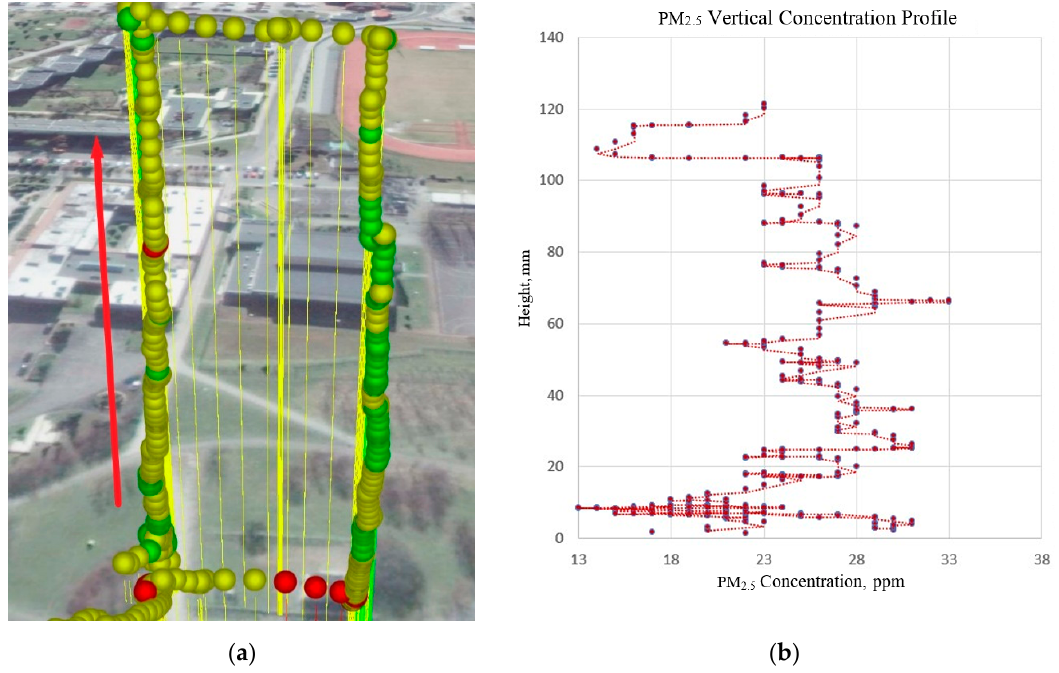
Figure 12. Flight route and measurement points visualization ( a ) for vertical concentration profile of PM 2.5 ( b ) for location number 2 (see Figure 1)—red arrow indicates ascending flight and data for the visualization chart.